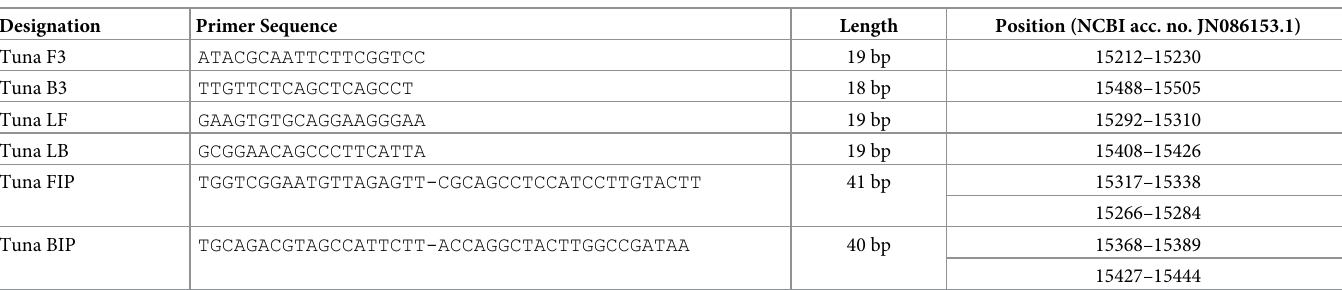
Table 1. cytB gene-targeting LAMP primer